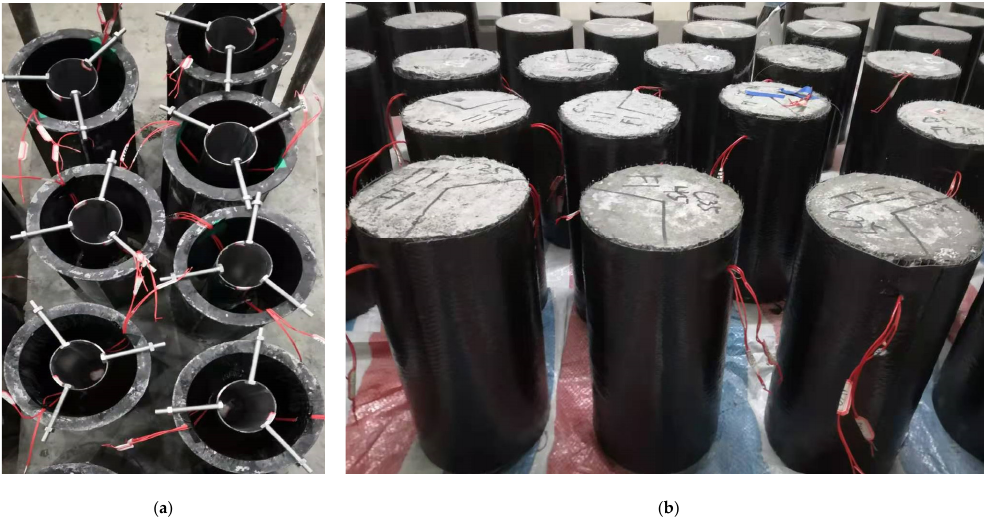
Figure 5. The process of preparing test specimens: ( a ) arrangement of internal steel tubes; ( b ) maintenance of CFRP jackets.